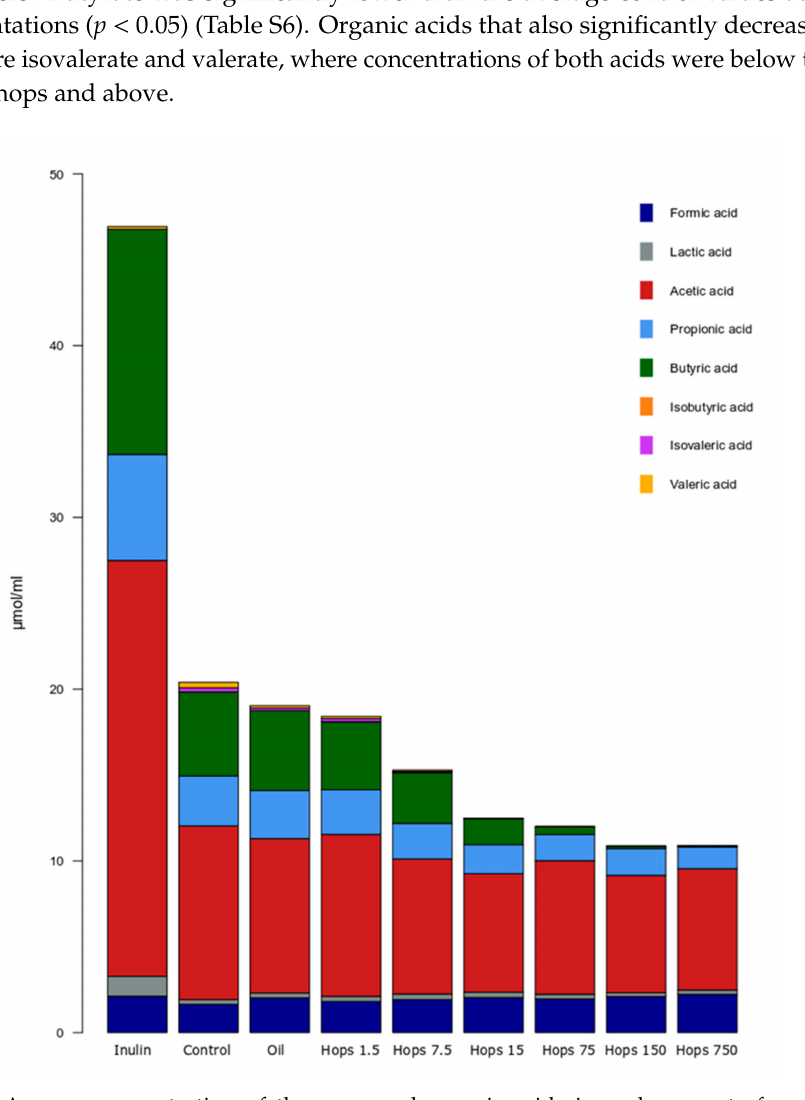
Figure 4. Average concentration of the measured organic acids in each separate fermentation. The substrates included hops at di ff erent concentrations (mg), oil-vehicle control, inulin and an unsupplemented control (results are the average over all time